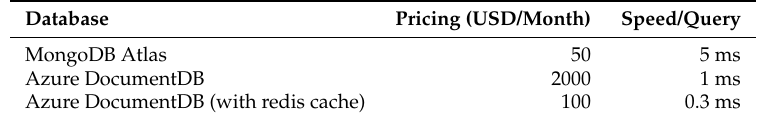
Table 2. Pricing and average query speed for MongoDB used for 100 devices and 3